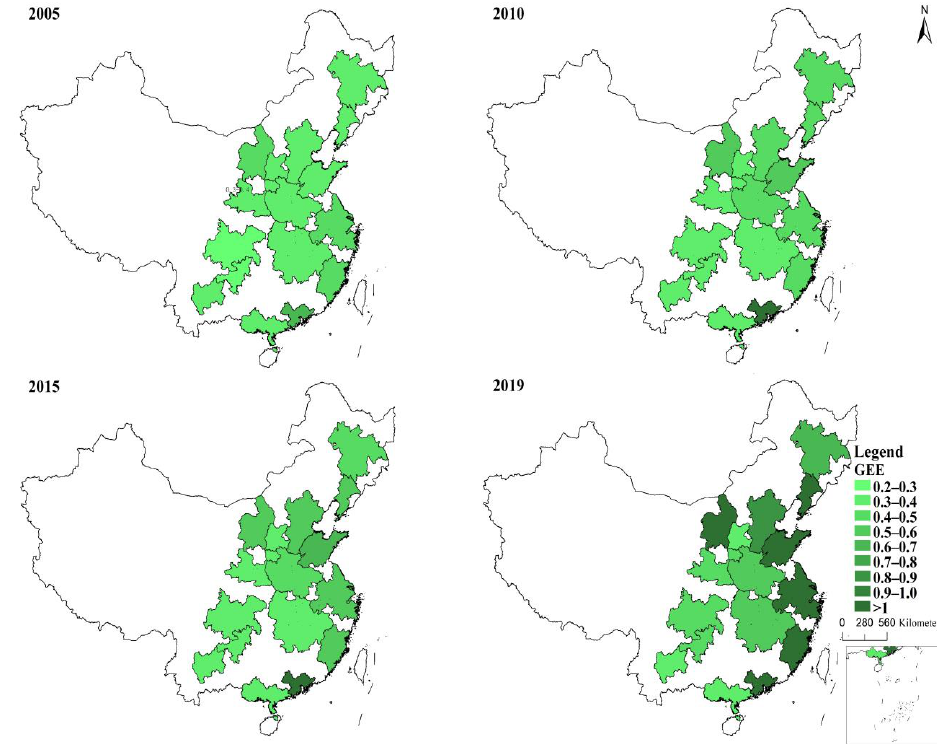
Figure 4. GUEUL of sample UAs for selected years. Land 2022 , 11 , x FOR PEER REVIEW